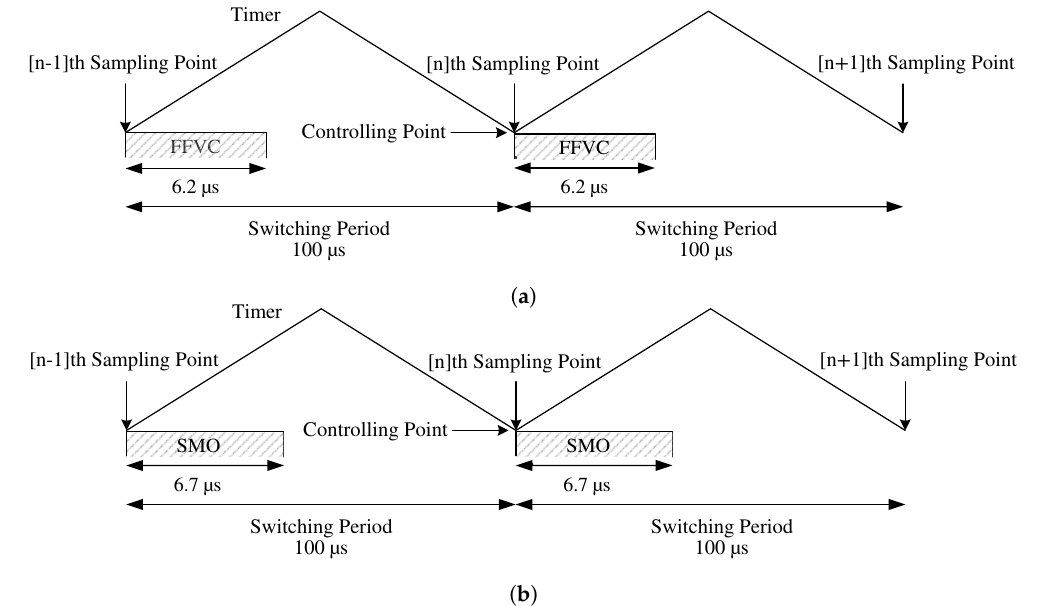
Figure 19. Timing diagrams for ( a ) Feedforward Voltage Control (FFVC) and ( b ) Sliding Mode Control (SMO).